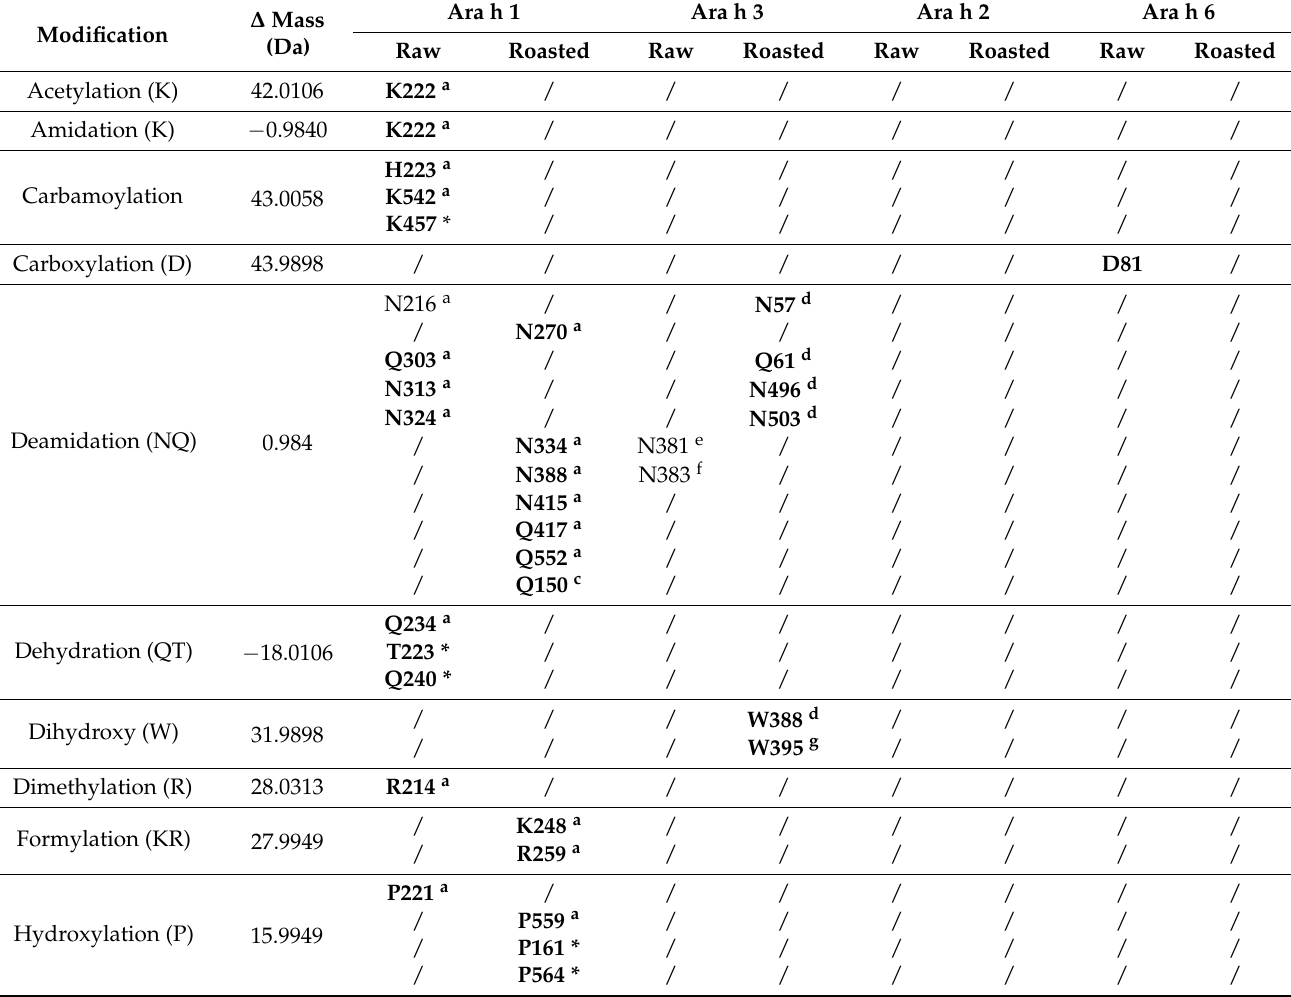
Table 1. Sites of modifications’ qualitative differences between raw and roasted samples of major peanut allergens summarized on dominant UniProt accession entries. Ara h 1—P43237 a ; E5G076